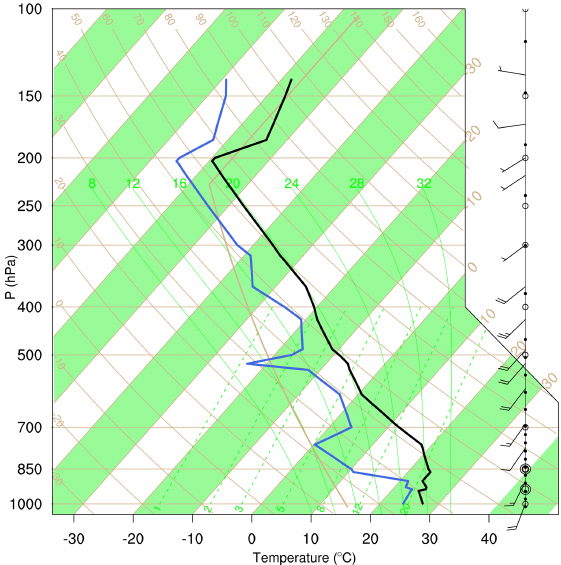
Figure 2. Sounding profiles for Beijing at 00:00UTC on 11 Au- gust 2017. The solid black and blue lines represent the temperature and dew point,